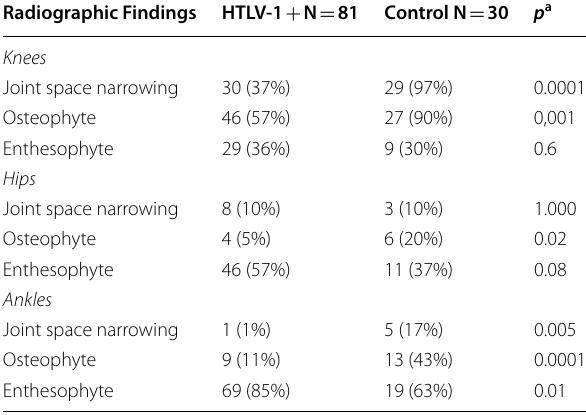
Table 3 Radiographic findings by joint in 81 patients infected with HTLV-1 and 30 controls with